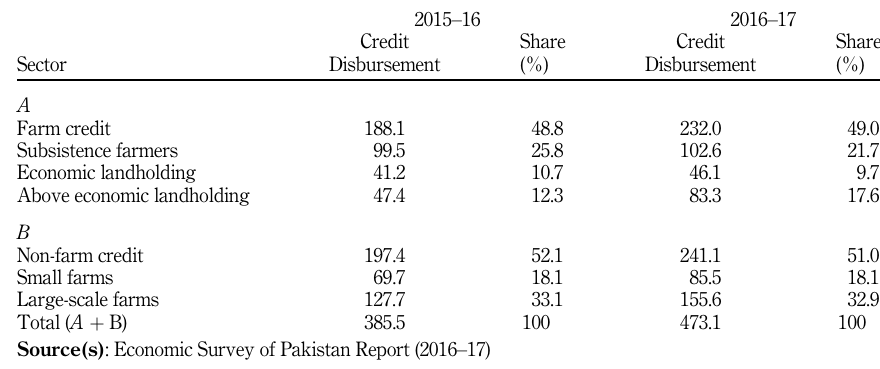
Table 3. Access to farm and nonfarm formal agricultural credit (PKR.